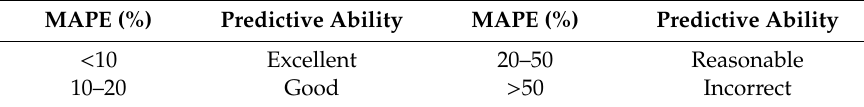
Table 1. The mean absolute percentage error (MAPE) criterion for model examination. MAPE